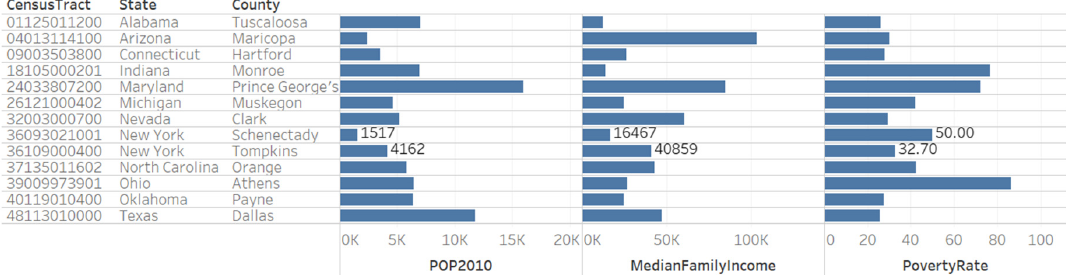
Figure 7. Comparison of population (2010), median family income and poverty rate for census tracts with food access pattern 1111111111111001 (not flagged from low-access tracts at 10 and 20 miles). The knowledge visualization provides new insights on the relationships that exists among these